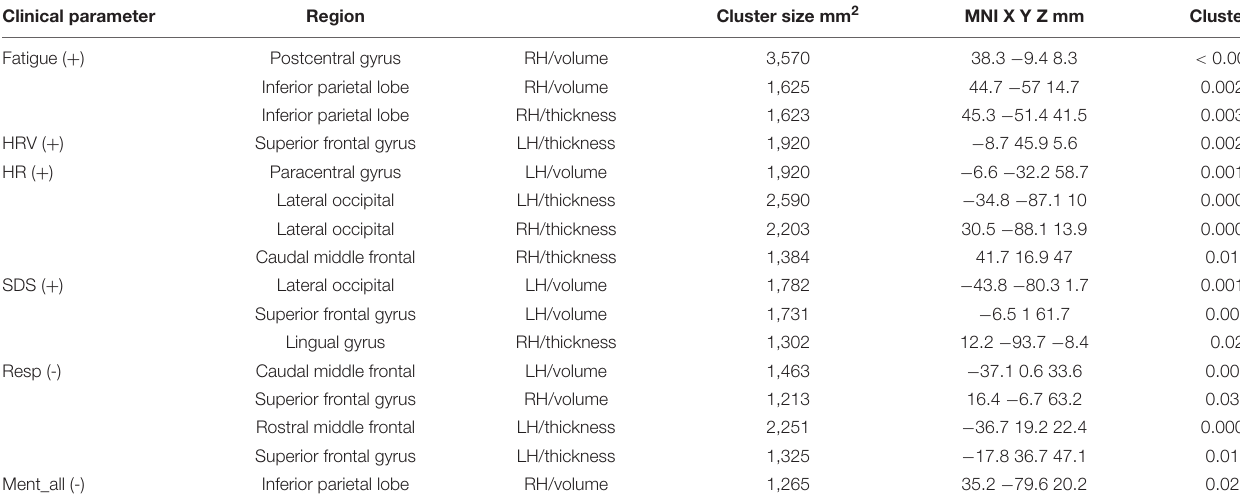
TABLE 4 | Significant clusters from cortical volume and thickness voxel-wise interaction-with-group regressions with six clinical regressors. Clinical